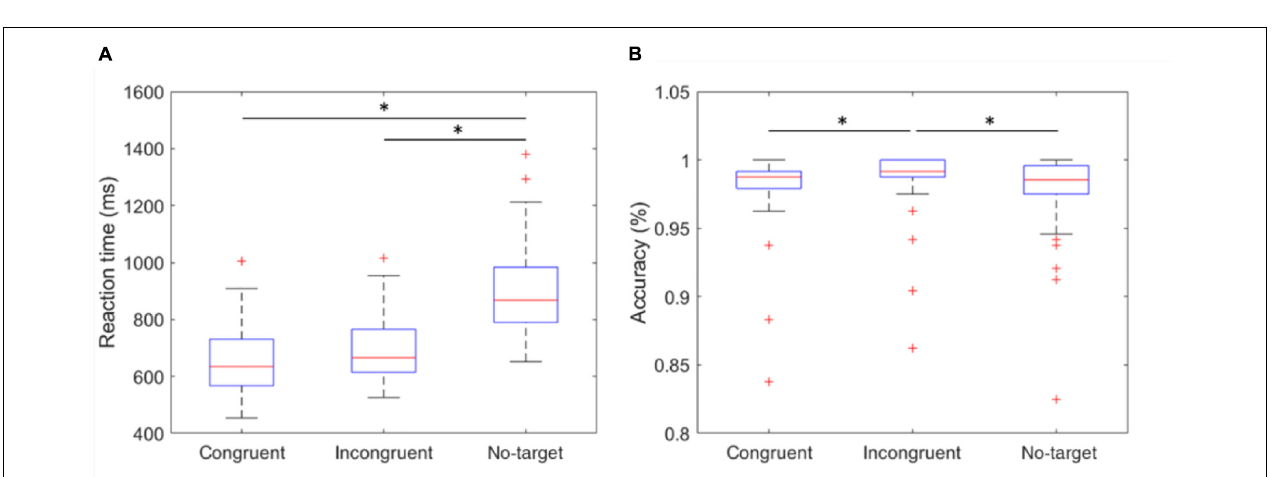
FIGURE 3 | System information flow. The EEG acquisition is conducted with the software in the computer through Bluetooth. The acquired signal could be applied to a BCI system; at the same time, it is transmitted to the monitoring system running on portable devices. In the system, the signal is computed to easily assess the parameters which are displayed in a pentagon plot.